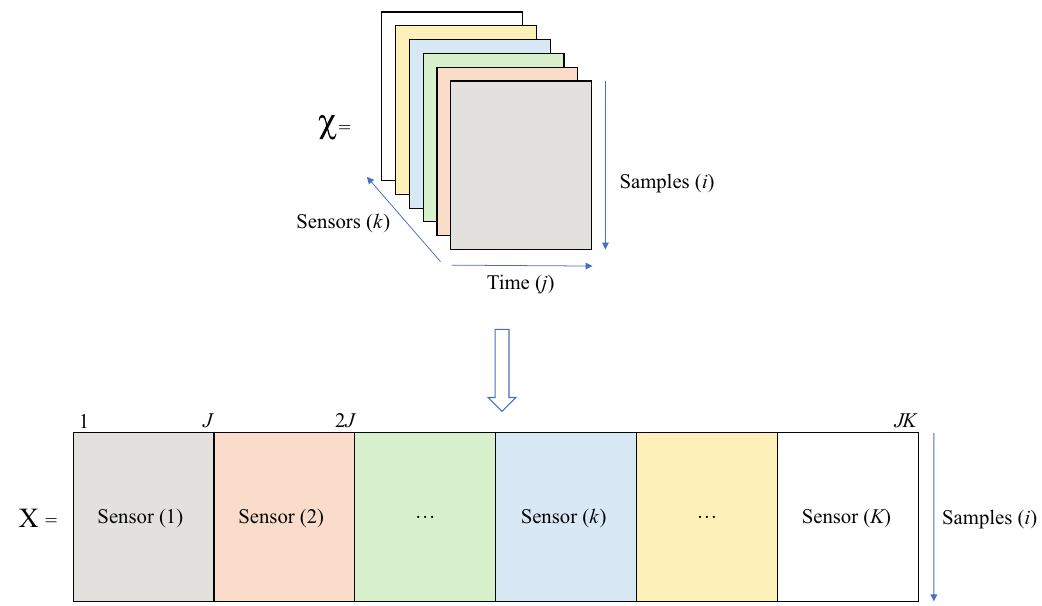
Figure 2. Unfolding of the third-order tensor X into matrix X